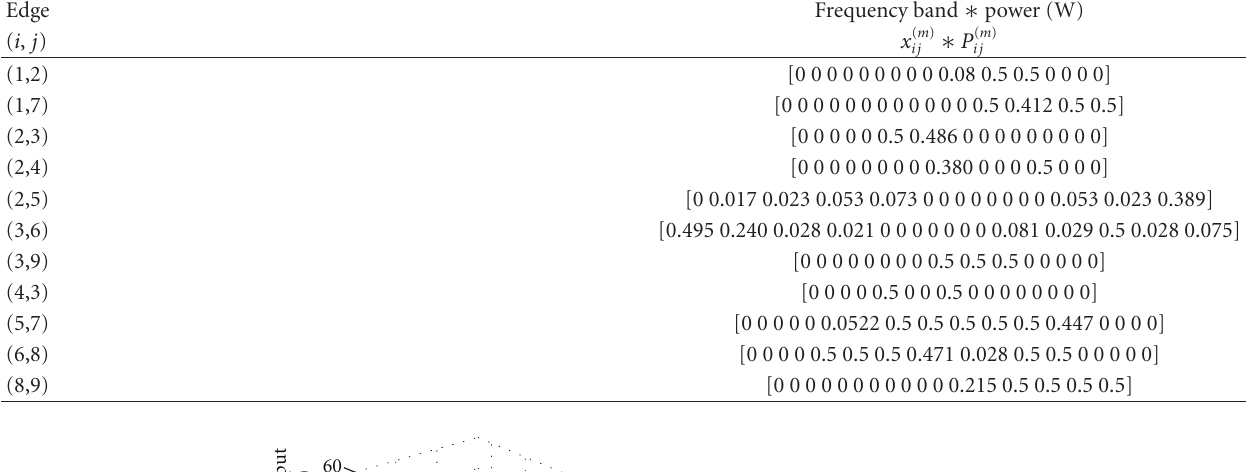
Table 5: Results for SS-SCR.